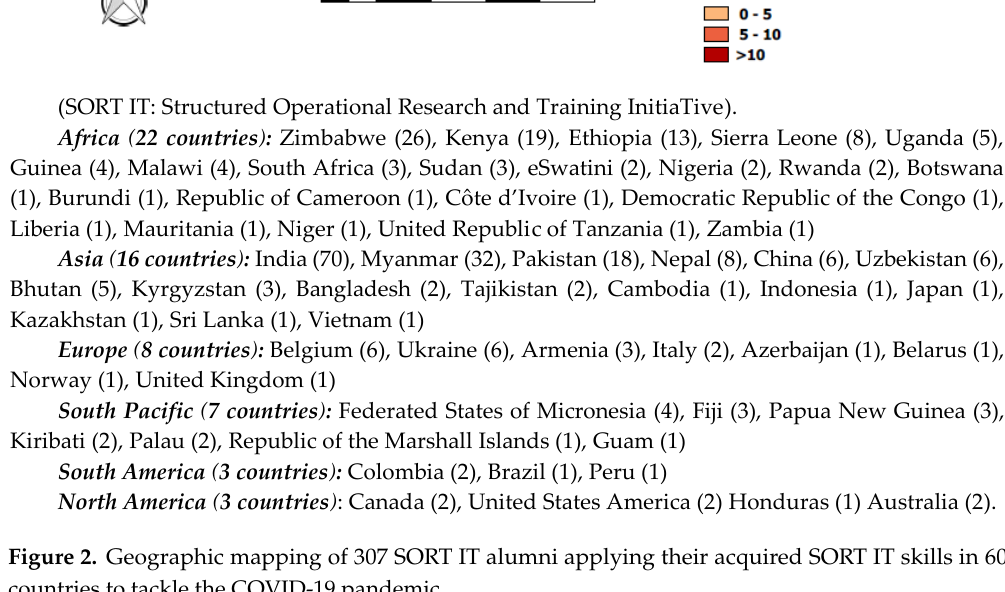
Figure 2. Geographic mapping of 307 SORT IT alumni applying their acquired SORT IT skills in 60 countries to tackle the COVID-19 pandemic.